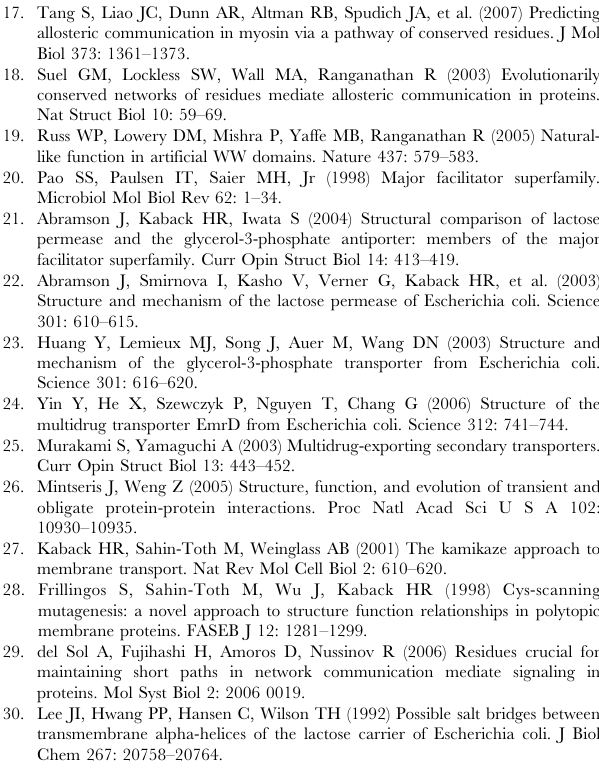
Figure S2 Likelihood ratios of IS, CN, co-evolution, and sequence conservation scores. Figure S4 Interaction networks of the high-IS residues of membrane protein transporters. Figure S5 Precision-recall curves of four evolutionary approaches. Figure S6 Interaction networks of the detected residues of LacY. Found at: doi:10.1371/journal.pcbi.1000522.s006 (0.08 MB PDF) Figure S7 Precision-recall curves of three algorithms for co- evolutionary analysis. Found at: doi:10.1371/journal.pcbi.1000522.s007 (0.03 MB PDF) Figure S8 Positions of the detected functional residues are shown with the Z-coordinates of MFS transporters (A) LacY, (B) GlpT, and (C) EmrD. Table S1 Differences of IS, CN, and sequence conservation score between central cavity and non-cavity region. Table S2 List of central cavity residues in lactose permease (LacY). Table S3 Interaction network of detected residues in LacY.